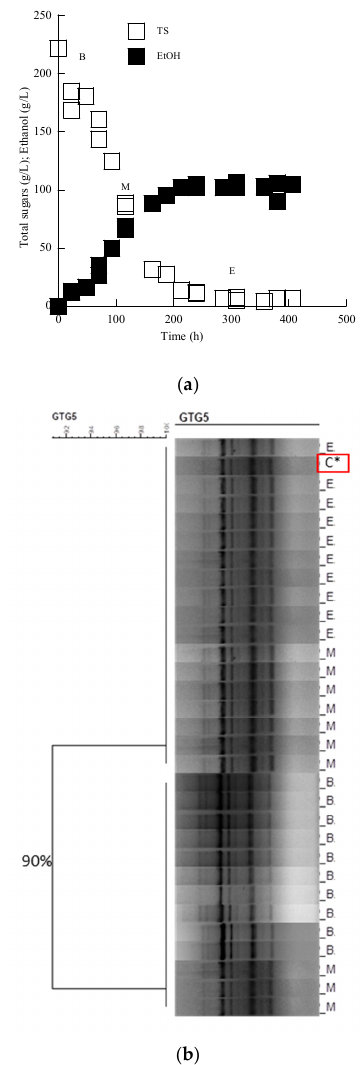
Figure 3. ( a ) Sugar and ethanol evolution of the S. cerevisiae LMBF Y-54 strain in must from the grape variety Assyrtiko. Each experimental point is the mean value of 2 independent measurements (SE for most experimental points ≤ 17%). ( b ) Dendrogram generated after cluster analysis of the digitized (GTG)5-PCR fingerprints of the 31 isolates from the beginning (B), middle (M) and end (E) of the fermentation kinetics in the grape must media. The control condition (C*) is the relative rep-PCR profile of the pure culture of the S. cerevisiae LMBF Y-54 strain. The dendrogram was constructed using the unweighted pair-group method using arithmetic averages with correlation levels expressed as percentage values of the Pearson correlation